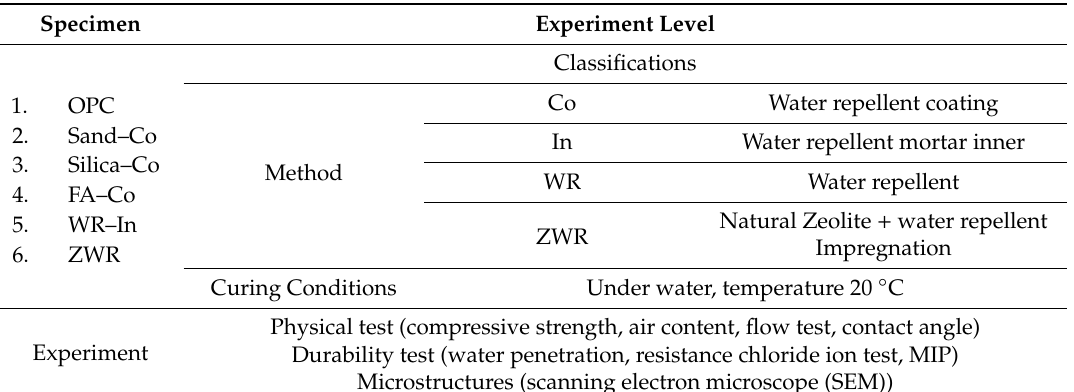
Table 1. Outline of